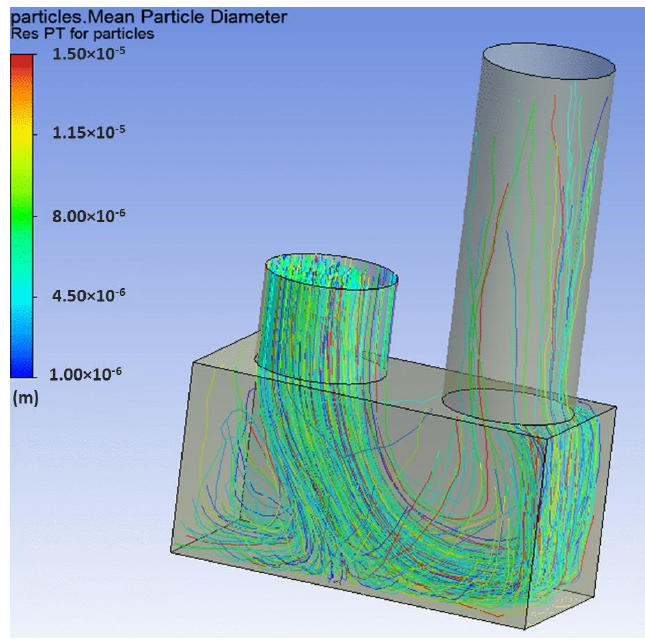
Figure 8. Case 3 box design showing tracks of particles that deposit on the wall.